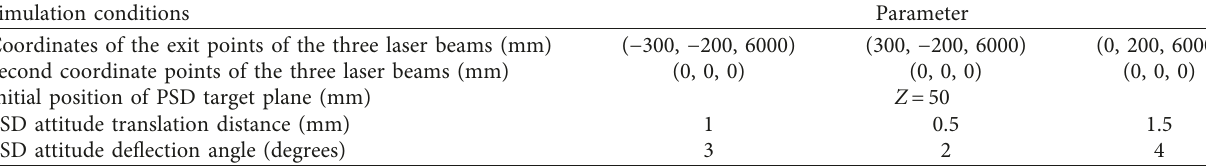
Table 2: Initial conditions of the simulation calculations.